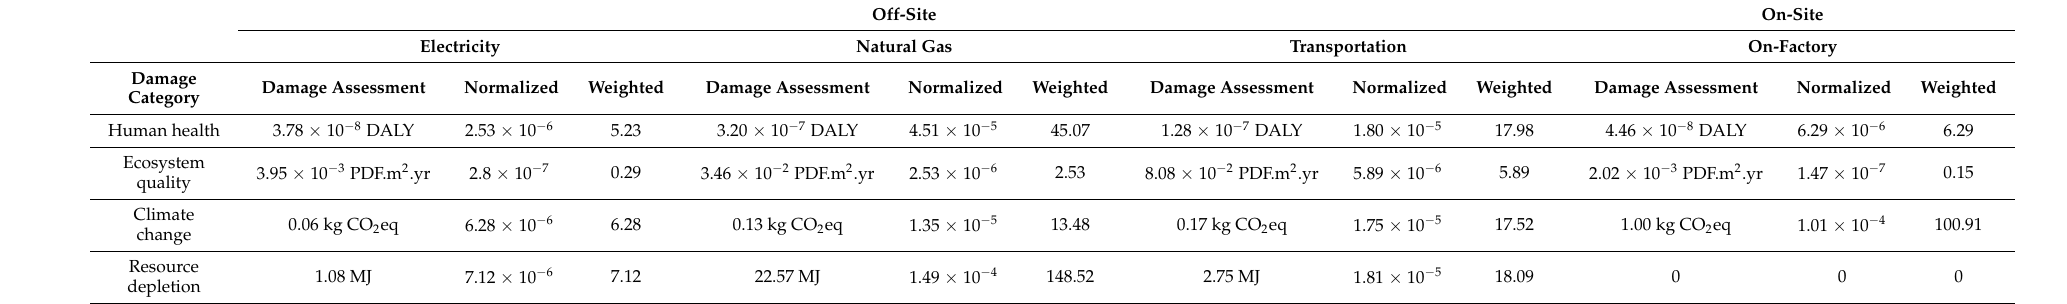
Table 3. Environmental impacts of the olive kernel oil production system based on different damage